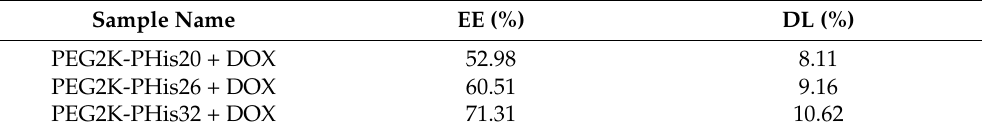
Table 1. Encapsulation efficiency (EE) and drug loading (DL) of DOX in